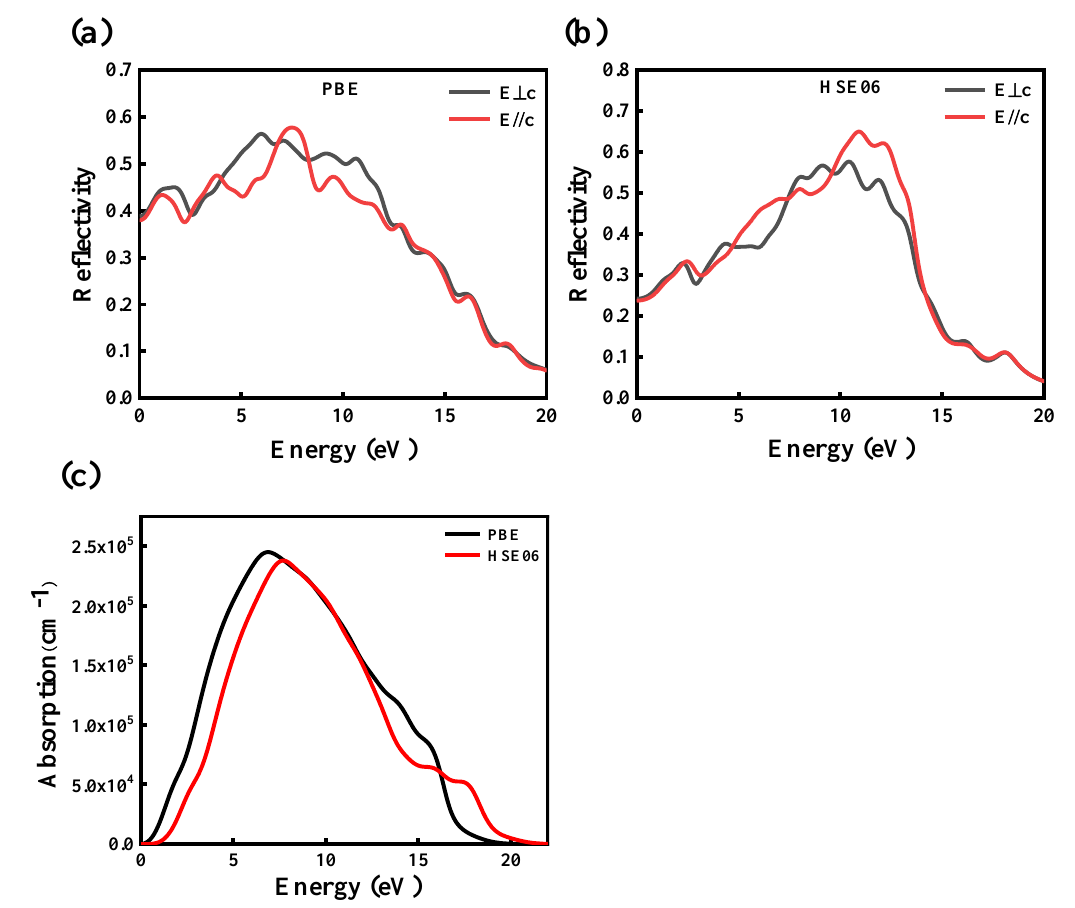
Figure 6. ( a , b ) The reflectance spectrum and ( c ) the absorption spectrum of CdGeAs 2. The absorption spectrum of CdGeAs 2 obtained according to Equation (6) is shown in Figure 6c. The absorption calculated by the PBE and HSE06 methods starts at about 0.09 eV and 0.72 eV, respectively, which corresponds to the bandgap value of the material. The strongest absorption peak calculated by the GGA–PBE method appears at 6.82 eV, and the strongest absorption peak calculated by the HSE06 method appears at 7.75 eV. The refractive index and the extinction coefficient of CdGeAs 2 , calculated by the GGA–PBE and HSE06 methods, are shown in Figure 7. The propagation speed of light wave in CdGeAs 2 determines the refractive index ( n ), and the attenuation of light wave determines the extinction coefficient ( k ). The average static refractive index calculated by the GGA–PBE method and the HSE06 method are 4.67 and 2.96, respectively. The extinction coefficients calculated by the GGA–PBE method have peaks at 2.07 eV and 4.95 eV. The peak values calculated by the HSE06 method were 2.79 eV and 5.93 eV, which is consistent with ε 2 ( ω ).